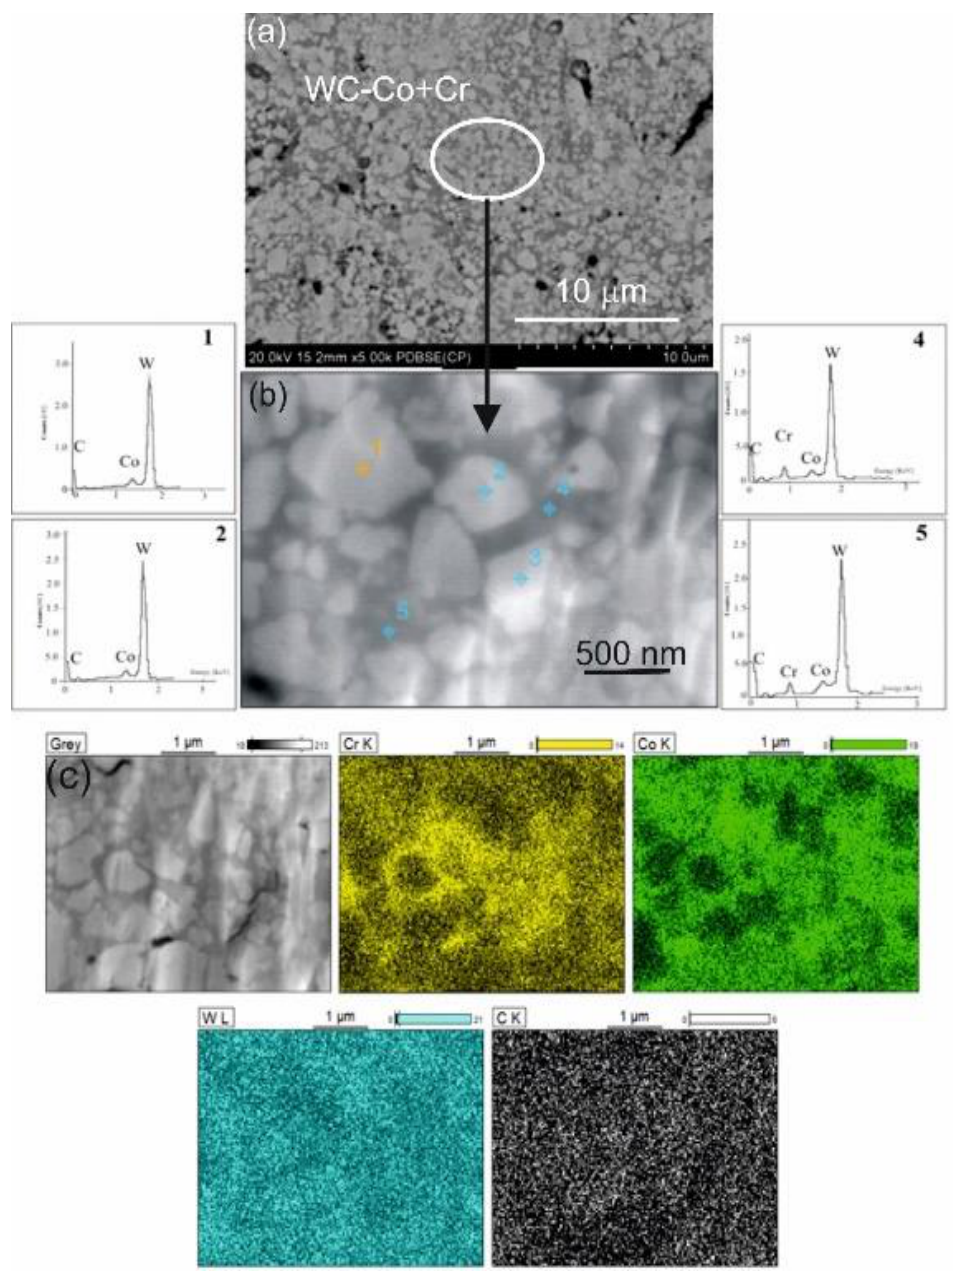
Figure 3. ( a ) Scanning micrographs of the composite coating (WC – Co + Cr) deposited on ductile cast iron interface with; ( b ) EDS spectra taken from the marked points: 1, 2, 4 and 5; ( c ) map of distribution of concentrations of Cr, Co, W, C taken from the region of interface.